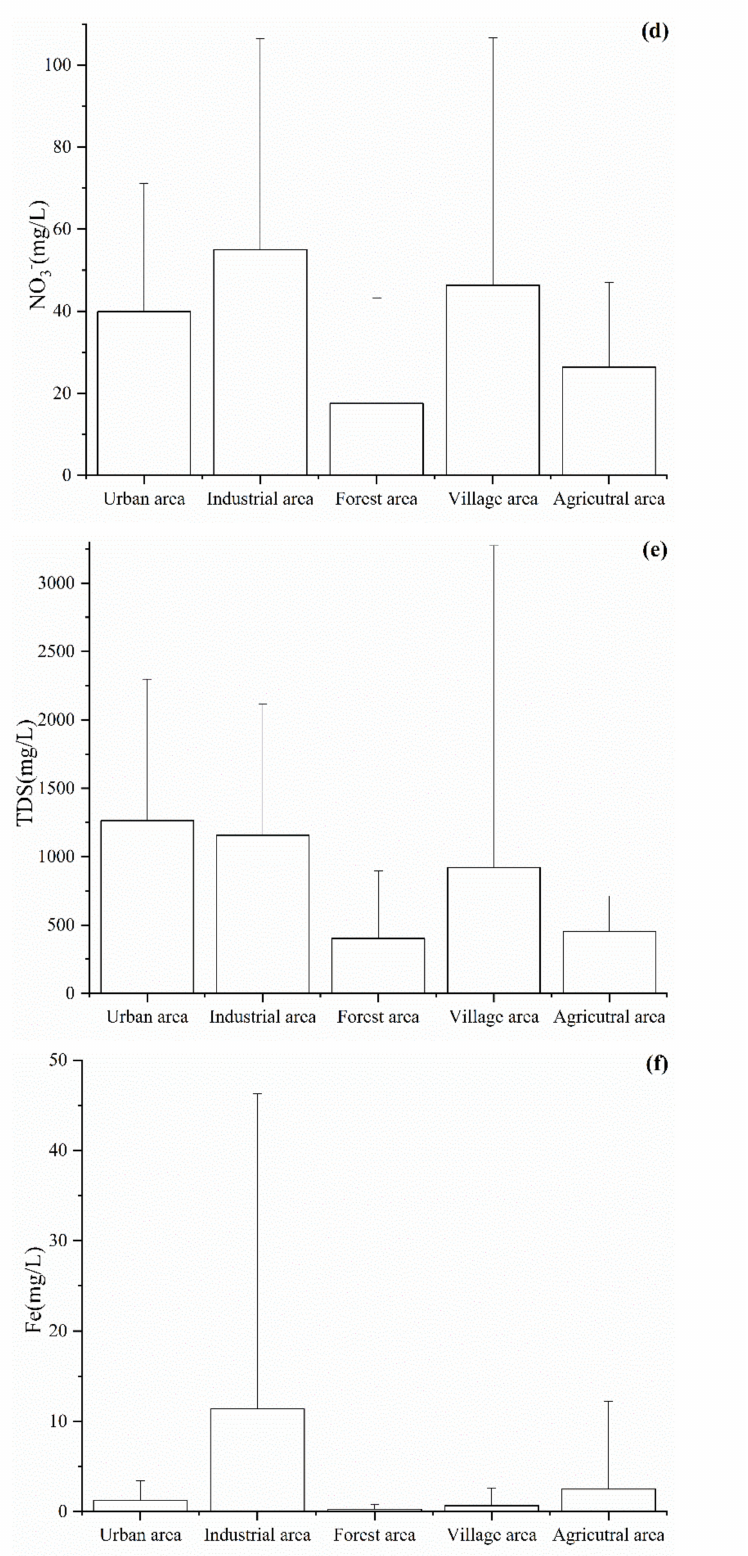
Figure 4. Spatial pattern of the ( a ) pH, ( b ) Cl − , ( c ) SO 4 2 − , ( d ) NO 3 − , ( e ) TDS and ( f ) Fe values in the Huangshui River